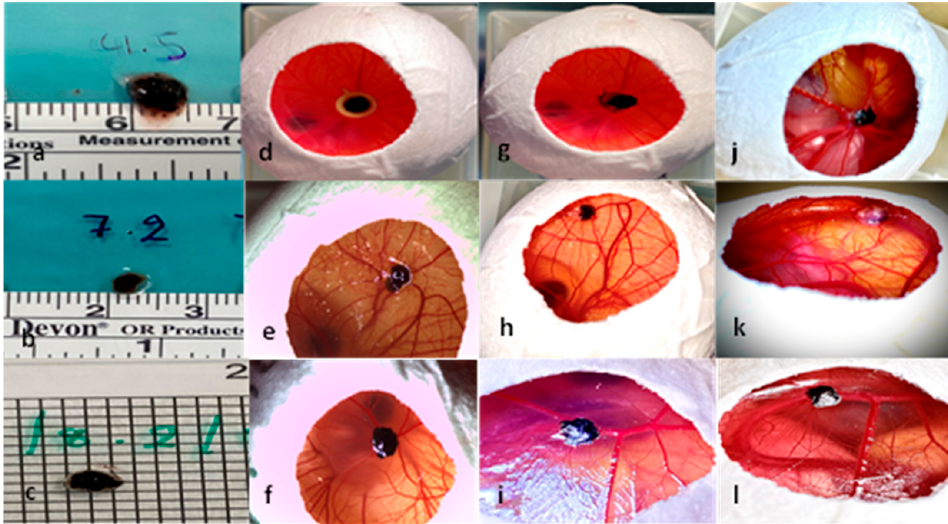
Figure 2. Presentation of the uveal melanoma patient-derived tumor graft development in the three experimental groups. ( a – c ) Uveal melanoma patient-derived grafts before implantation, ( d ) implan- tation of tumor sample with Matrigel and a ring on ED7, ( e ) implantation of a tumor sample with Matrigel without a ring on ED7, ( f ) implantation of a tumor graft without Matrigel or a ring on ED7, ( g ) tumor graft on ED8 after ring removal with loss of cohesion and dissociation of the tumor margins, ( h ) tumor graft on ED8 after implantation only with Matrigel, ( i ) tumor graft on ED8 after implantation without Matrigel or a ring, ( j ) tumor growth on ED18 in group 1 with Matrigel and a ring, ( k ) tumor growth on ED18 in group 2 with Matrigel, and ( l ) tumor growth on ED18 in group 3 without Matrigel or a